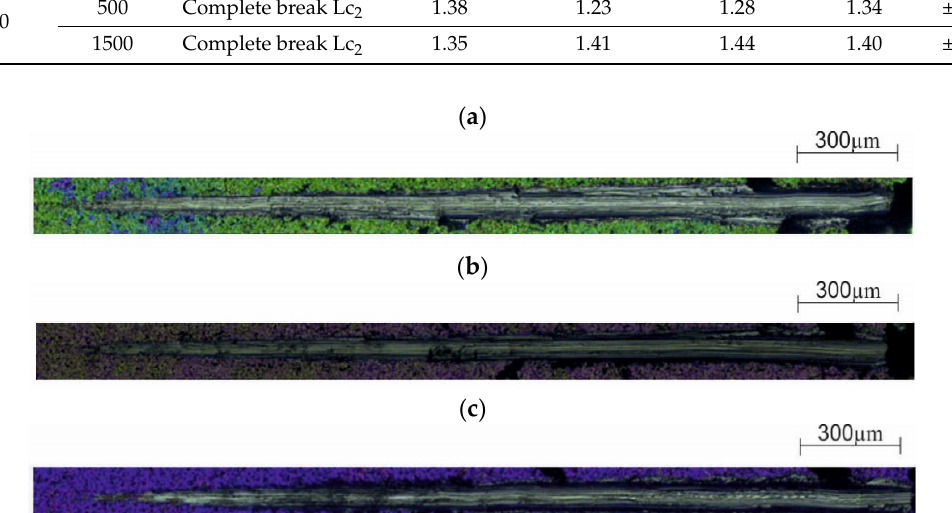
Figure 14. Results of the adhesion tests for the ZnO layer deposited at 1500 cycles (sandblasted): ( a ) 100 ◦ C, ( b ) 200 ◦ C, ( c ) 300 ◦